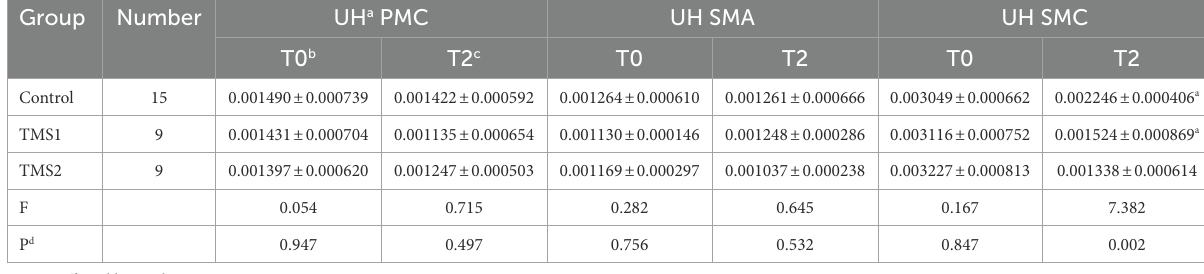
TABLE 3 Comparison of HbO2 concentration in the unaffected hemisphere ROI in the three groups before and after treatment. Group